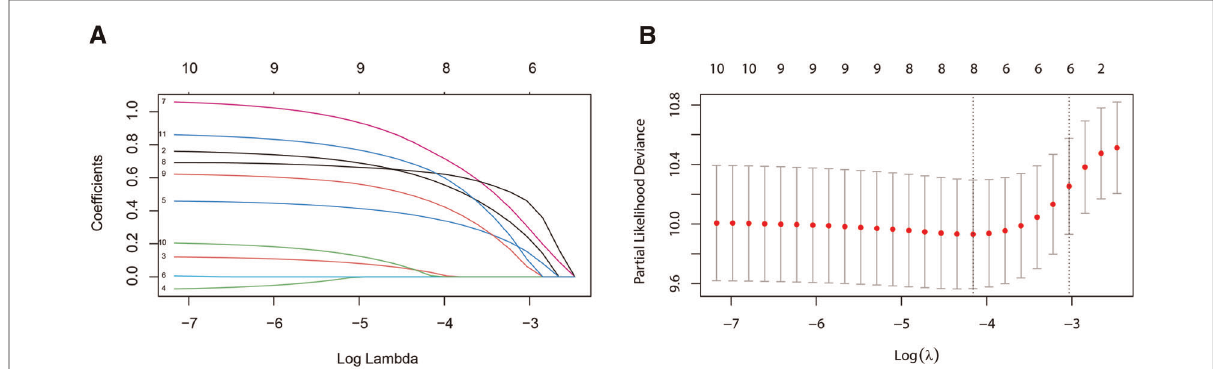
FIGURE 3 Variable selection by the LASSO binary logistic regression model. A coef fi cient pro fi le plot was constructed against the log (lambda) sequence. ( A ) Six variables with nonzero coef fi cients were selected by deriving the optimal lambda. ( B ) Following veri fi cation of the optimal parameter (lambda) in the LASSO model, we plotted the partial likelihood deviance curve vs. log (lambda) and drew dotted vertical lines based on 1 standard error criteria. LASSO, least absolute shrinkage and selection operator.